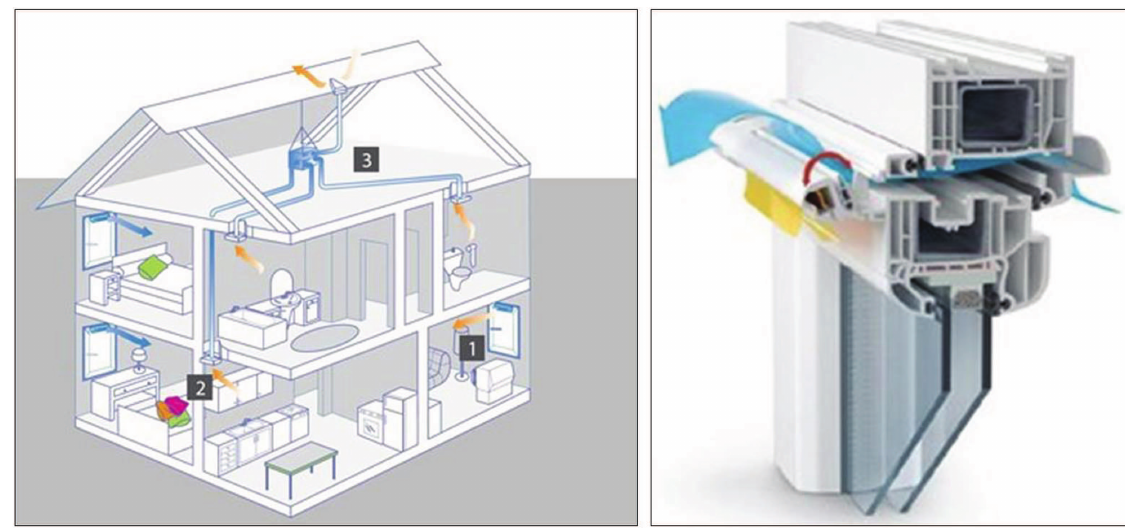
Fig. 5. Radon corrective measures – a hybrid ventilation